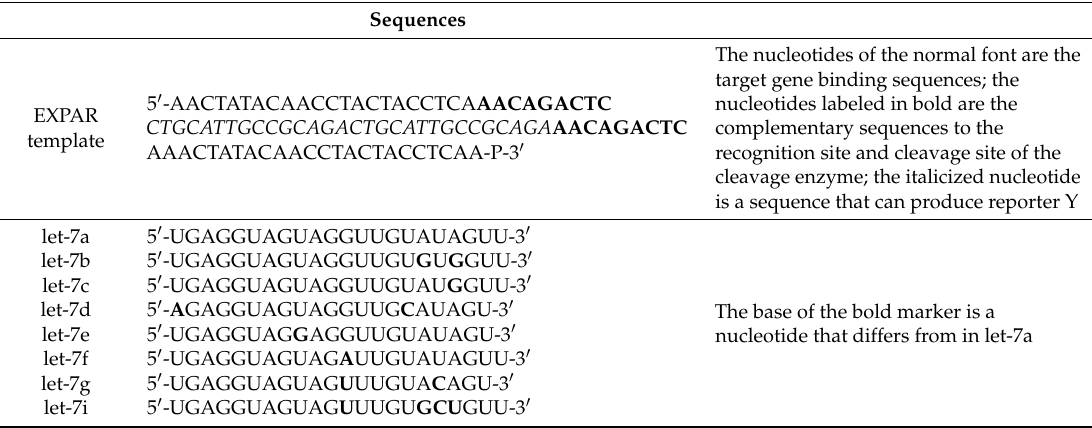
Table 1. Sequences of the oligonucleotides (In EXPAR template, the nucleotides labeled in bold are the complementary sequences to the recognition site and cleavage site of the cleavage enzyme; the italicized nucleotide is a sequence that can produce reporter